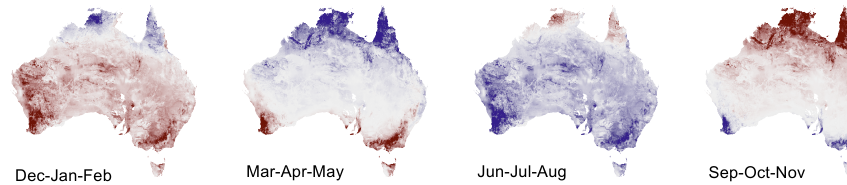
Fig. 10. Seasonal mean radon flux anomalies for July 1979–June 2010.